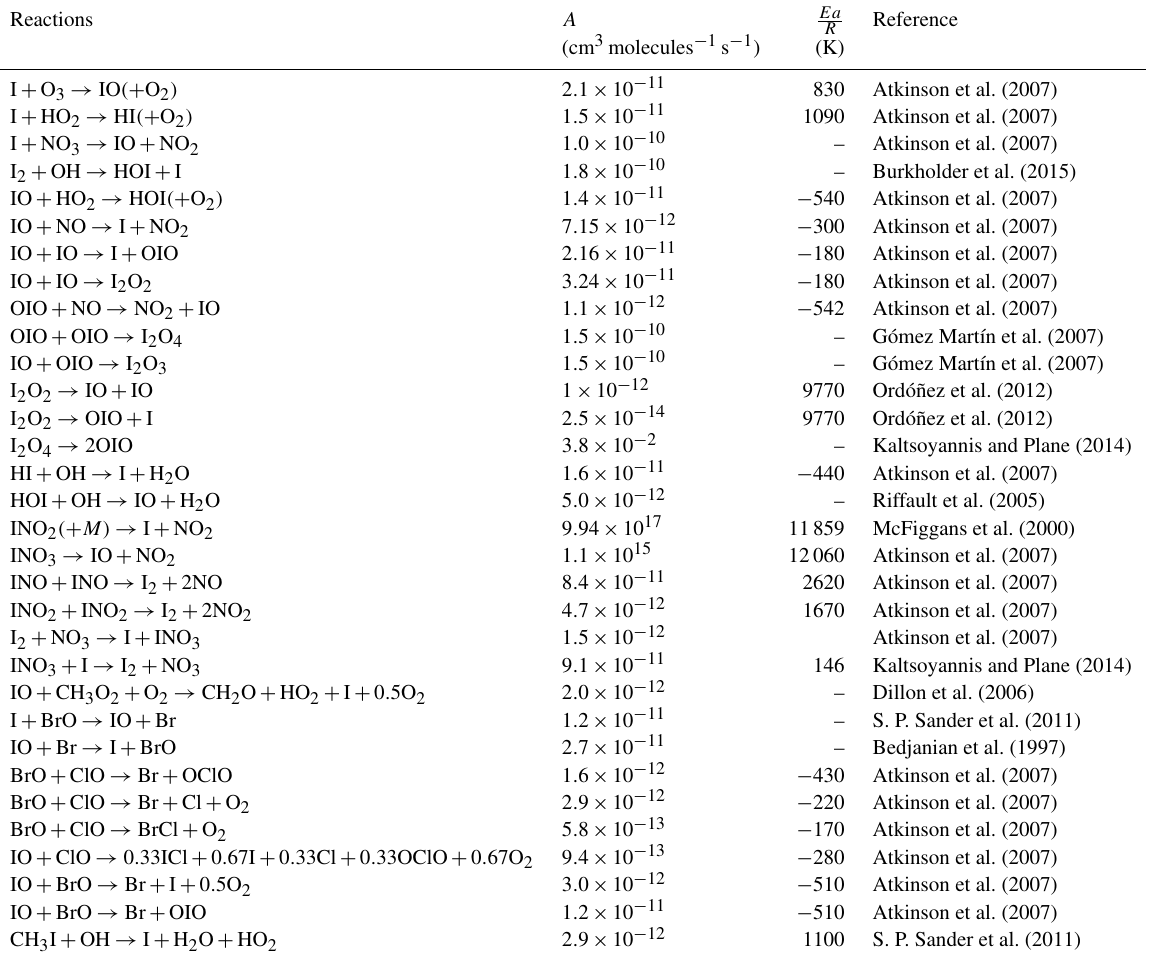
(cid:16) T (cid:17) a . 300